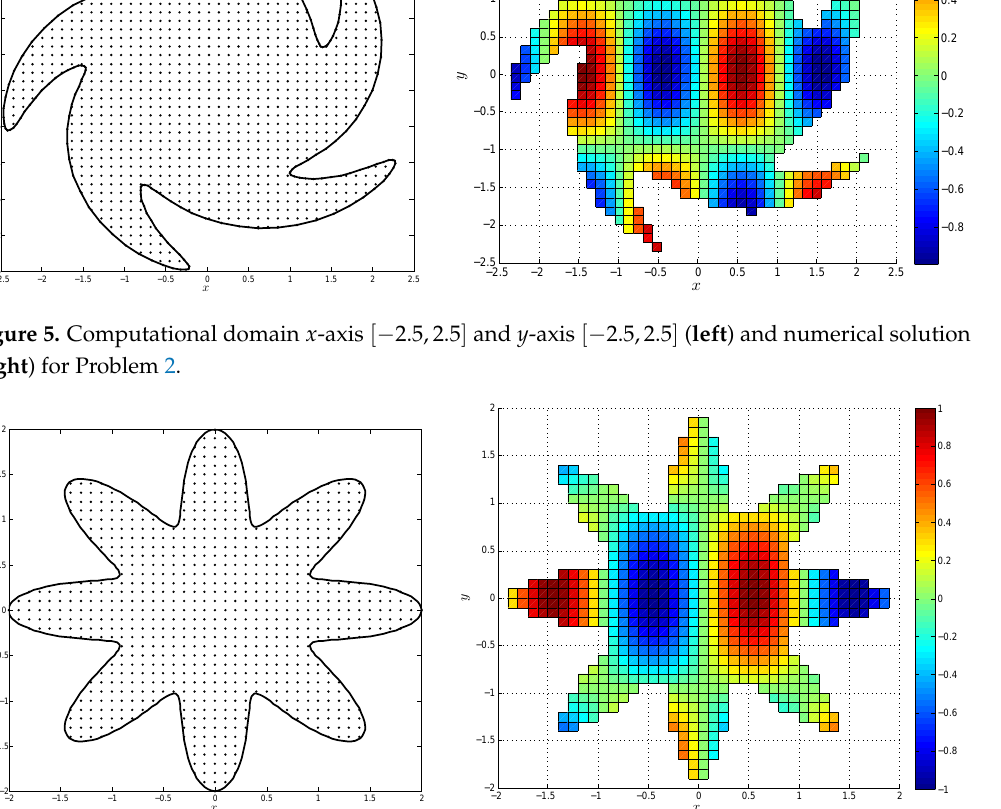
Figure 6. Computational domain x -axis [ − 2,2 ] and y -axis [ − 2,2 ] ( left ) and numerical solution ( right ) for Problem 2.